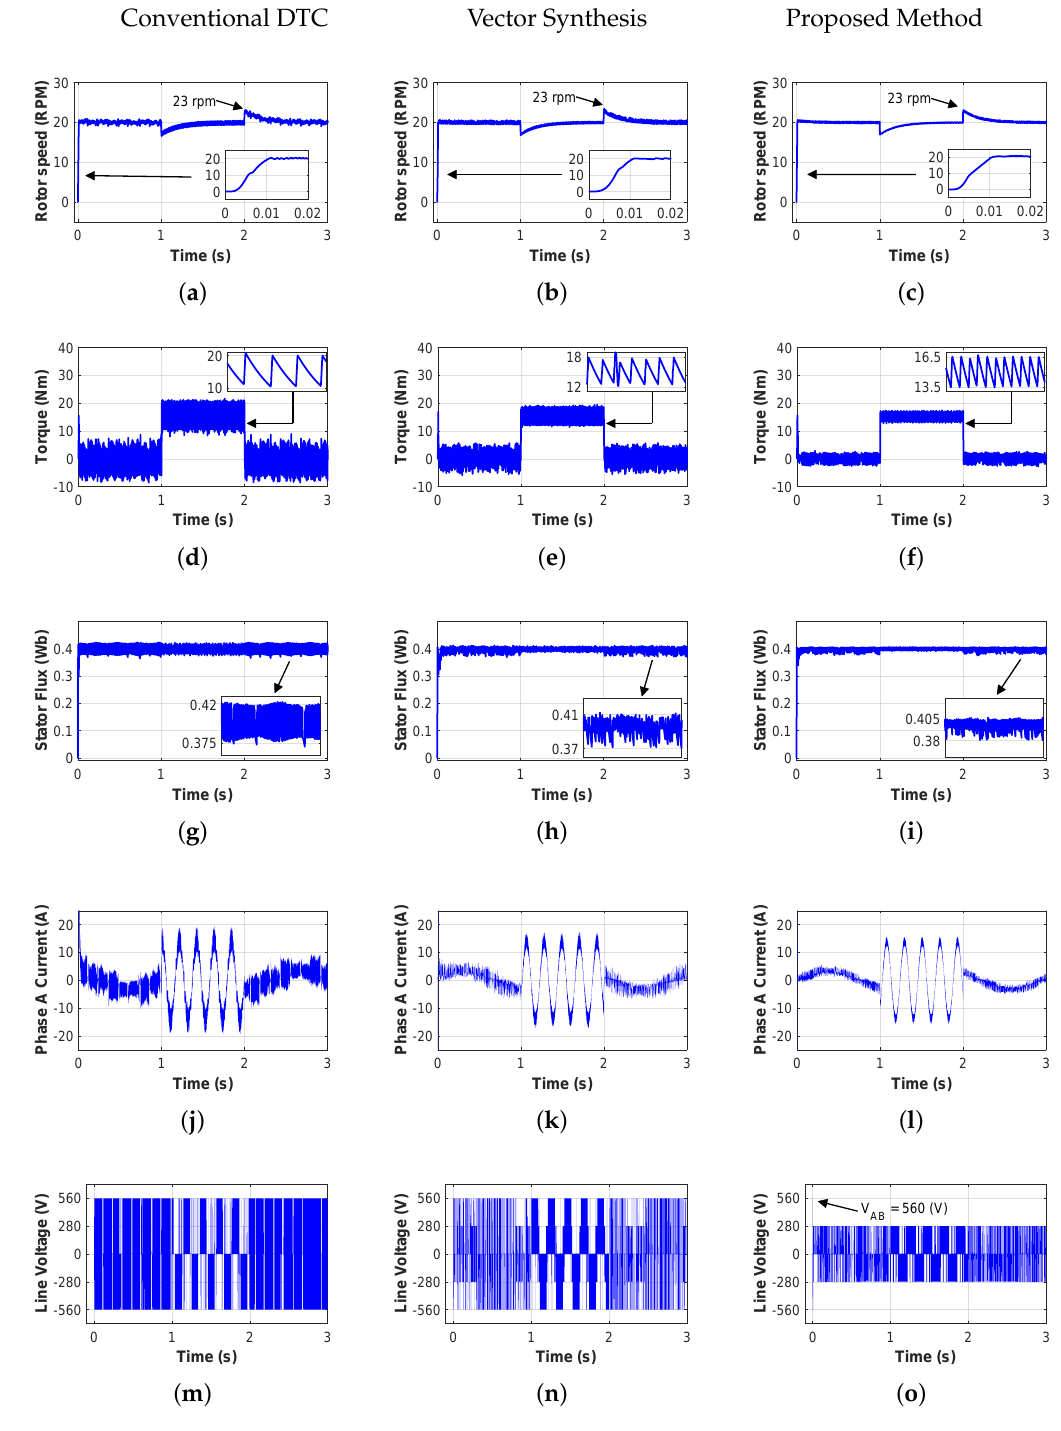
Figure 8. Simulation results for 20 rpm under 15 N · m load torque disturbance: ( a – c ) rotor speed response; ( d – f ) motor torque; ( g – i ) stator flux; ( j – l ) input current; ( m – o ) line